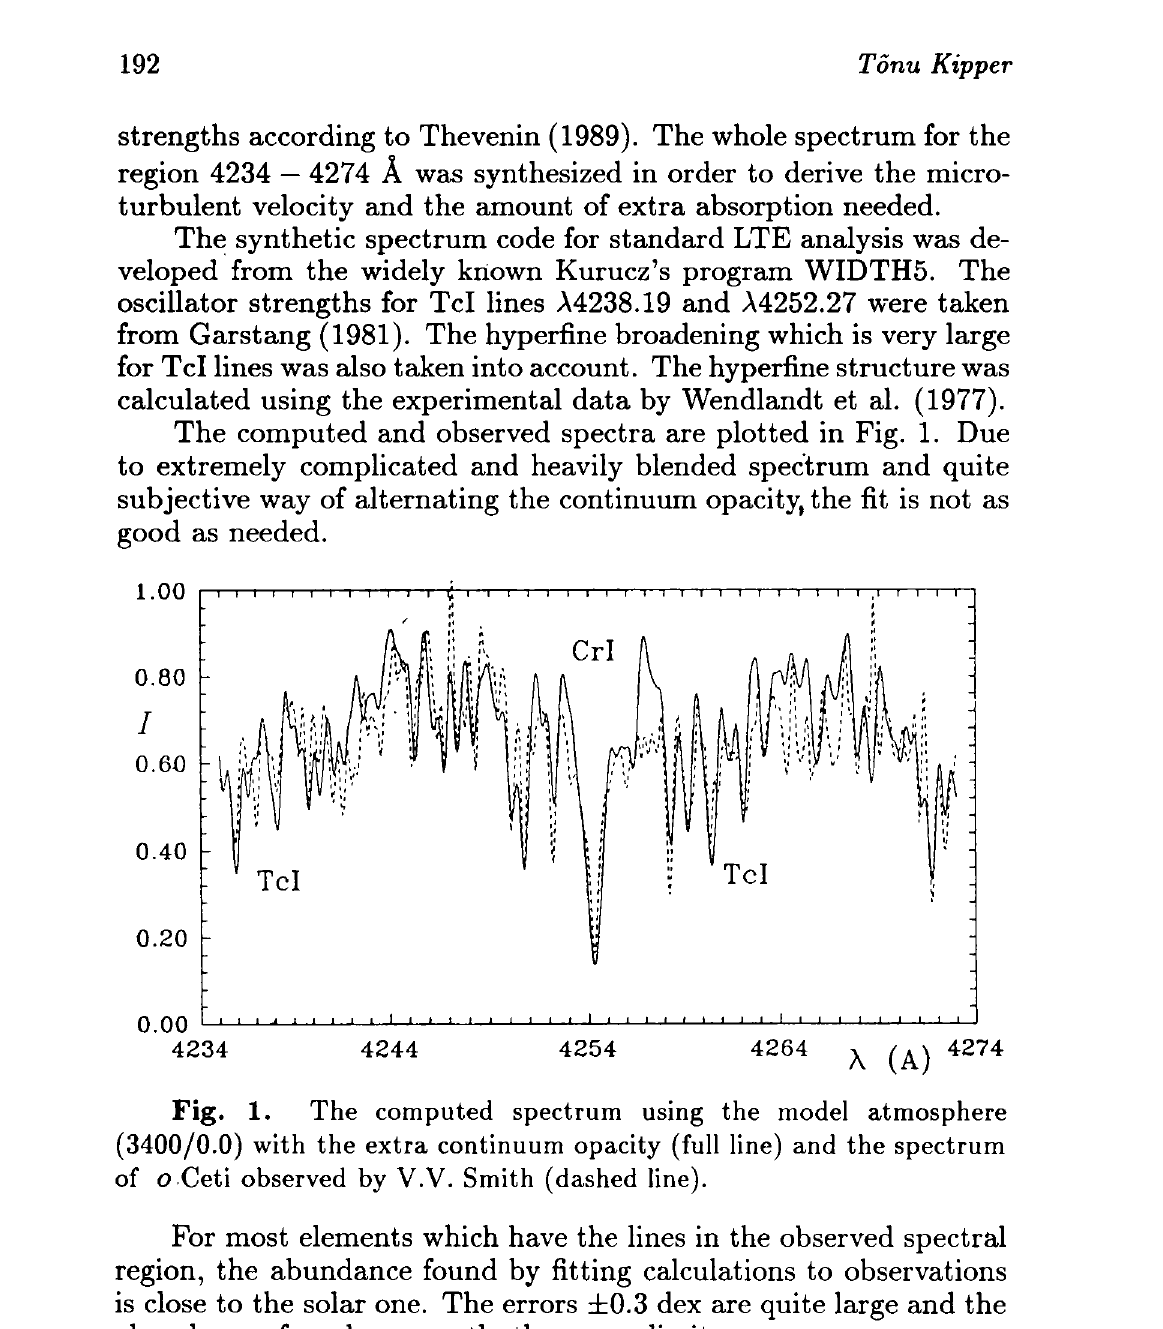
Fig. 1. The computed spectrum using the model atmosphere (3400/0.0) with the extra continuum opacity (full line) and the spectrum of o Ceti observed by V.V. Smith (dashed